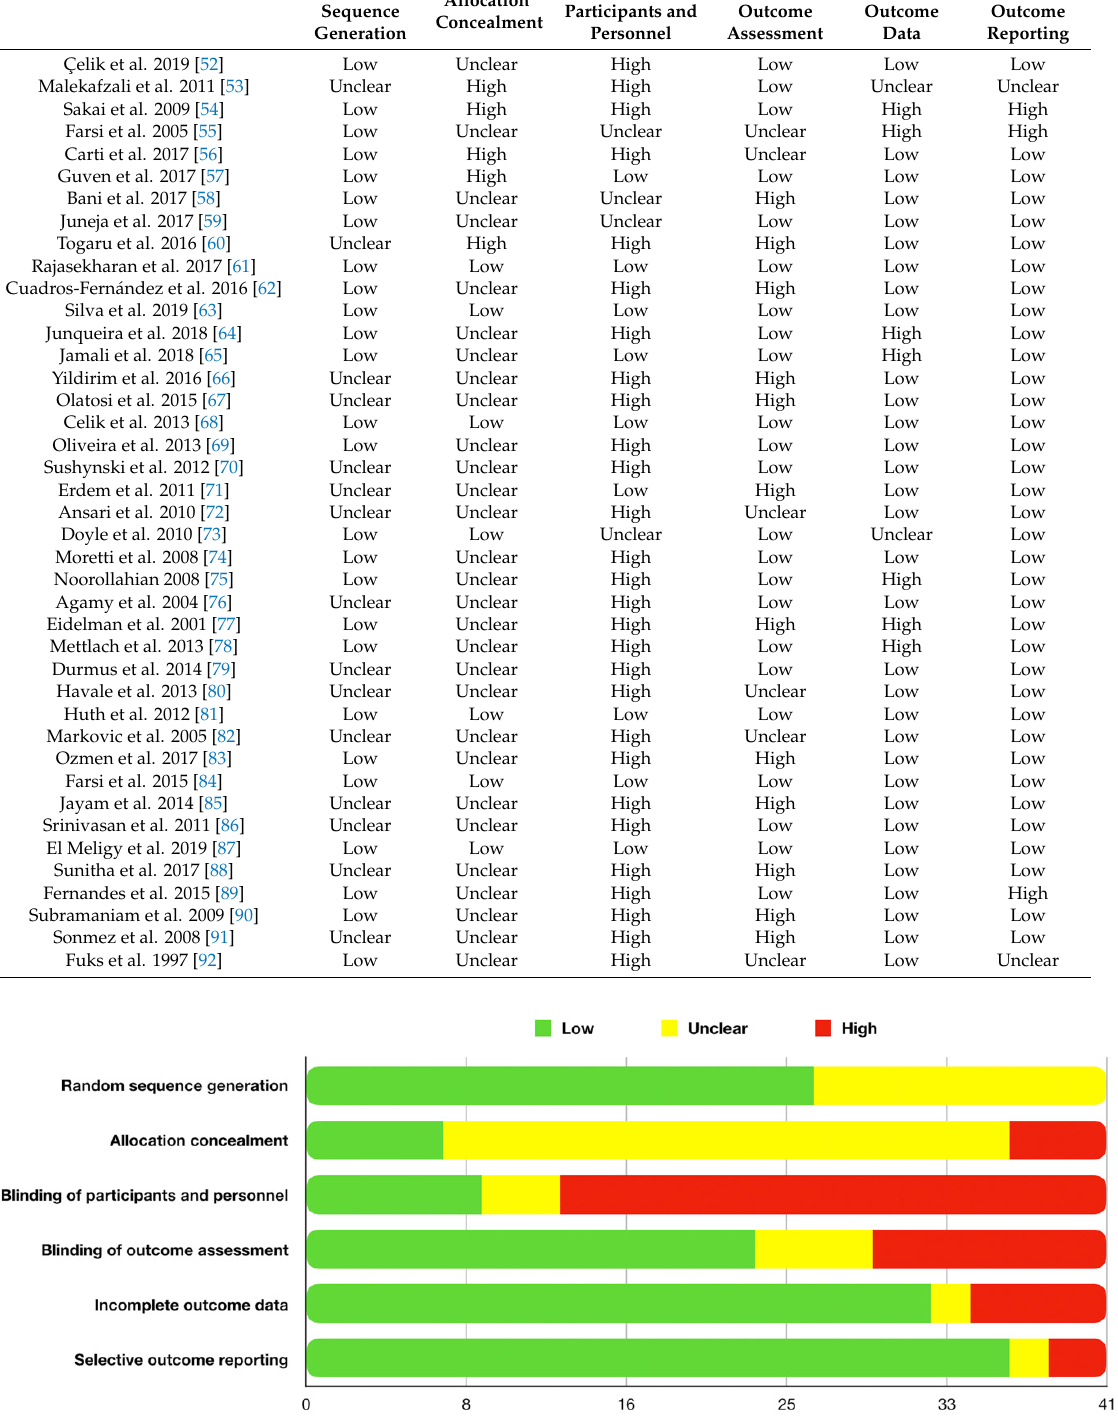
Figure 2. Overall risk of bias.